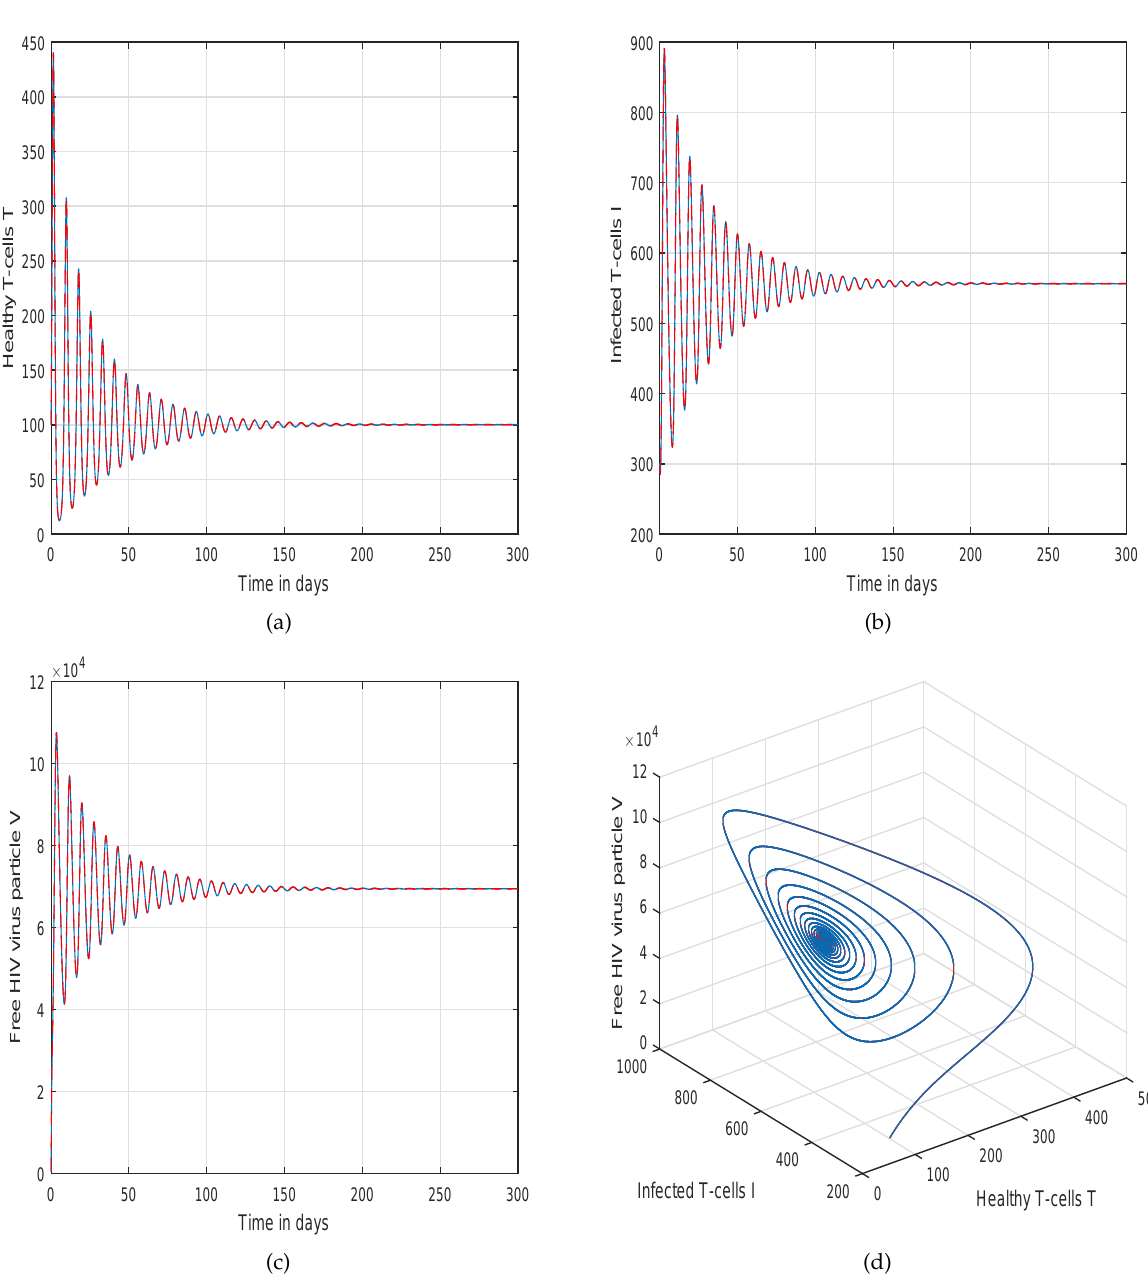
Figure 1. Illustration of the solution pathway of ( a ) healthy CD4 + T-cells, ( b ) infected CD4 + T-cells, ( c ) free HIV virus particles and ( d ) chaotic behavior of the proposed fractional model (2) of HIV infection with fractional-order ϑ =